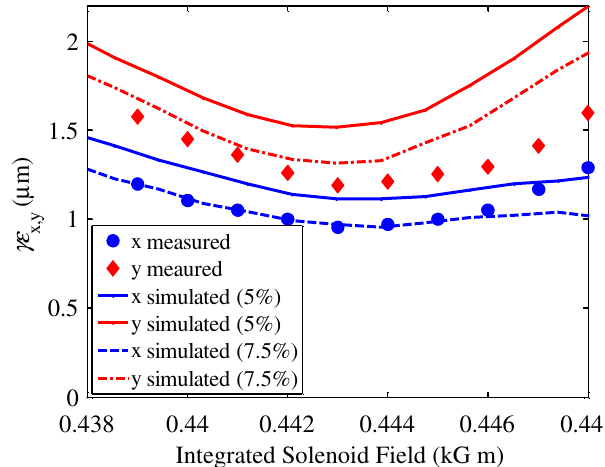
FIG. 34. (Color) Measured and simulated emittance vs gun- solenoid field. The measured emittances use a 5% area-cut, while simulations are shown for 5% and 7.5%. The bunch charge is 1 nC here and the gun exit electron energy is 5.75 MeV, explaining the lower solenoid field strength here than in Fig. 31.